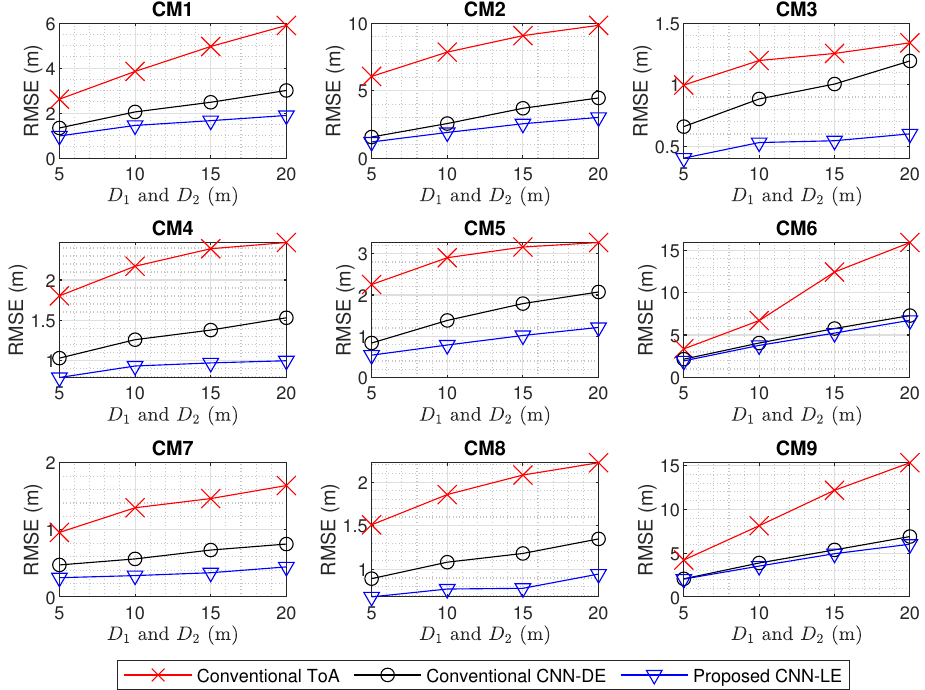
Figure 9. RMSE ( y -axis) across the area size ( x -axis, D 1 = D 2 ). CM# data is used for both training and test.